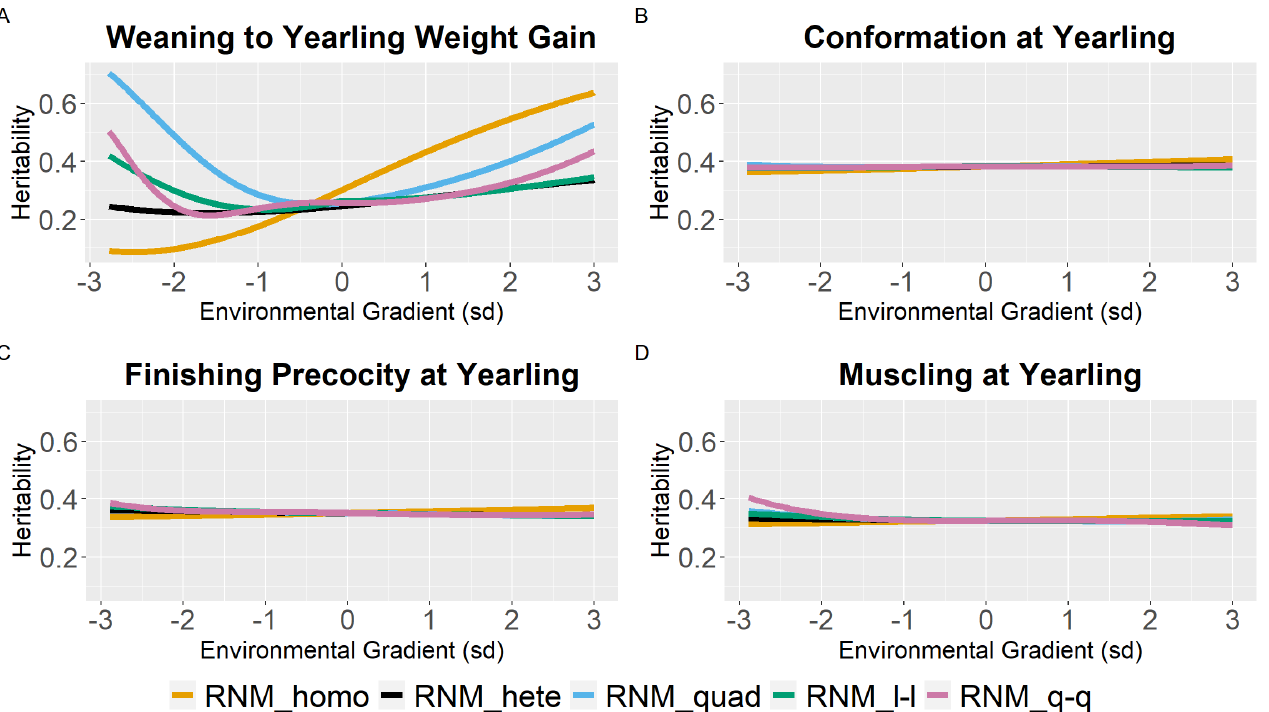
Figure 2. Heritability estimates (h 2 ) for weaning to yearling weight gain ( A ), conformation ( B ), finishing precocity ( C ), and muscling ( D ) at yearling traits in Nellore cattle according to the environmental gradient, for different reaction norm models. RNM_homo: linear homoscedastic; RNM_hete: linear heteroscedastic; RNM_quad: quadratic heteroscedastic; RNM_l-l: spline linear–linear heteroscedastic; RNM_q-q: spline quadratic–quadratic heteroscedastic.